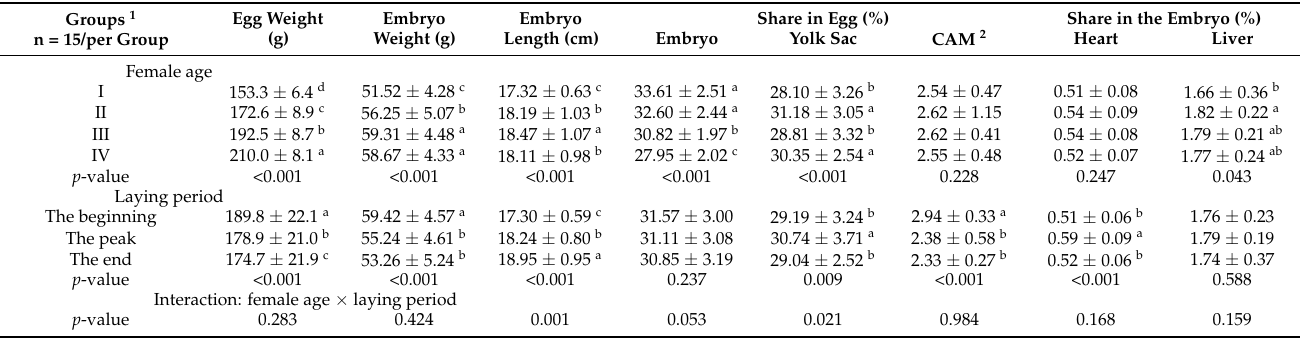
Table 2. Embryonic development of goose embryos on the 22nd day of incubation.